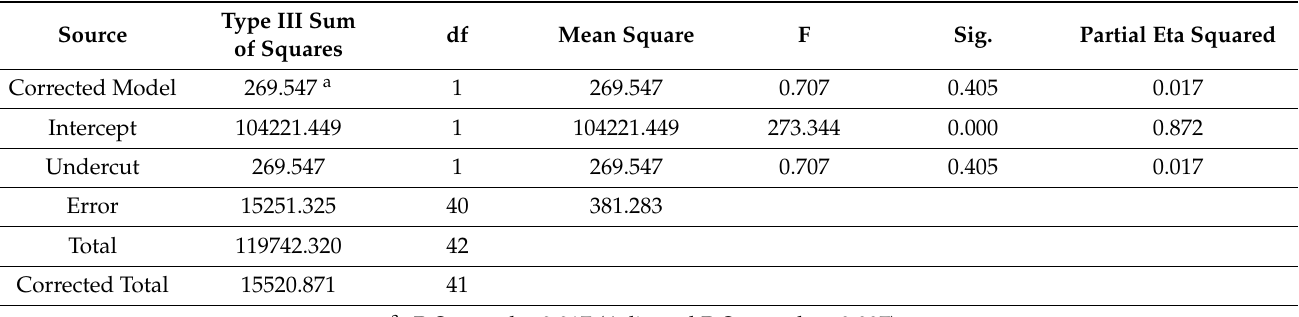
Table 6. ANOVA test of undercut